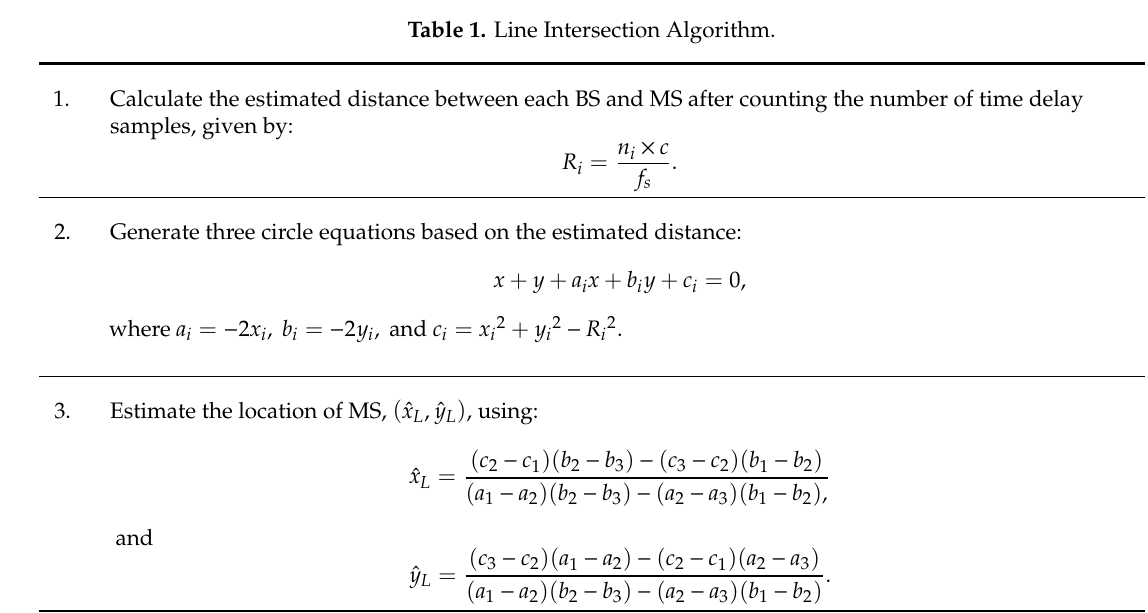
Table 2. Comparison Approach of Intersection Distances .